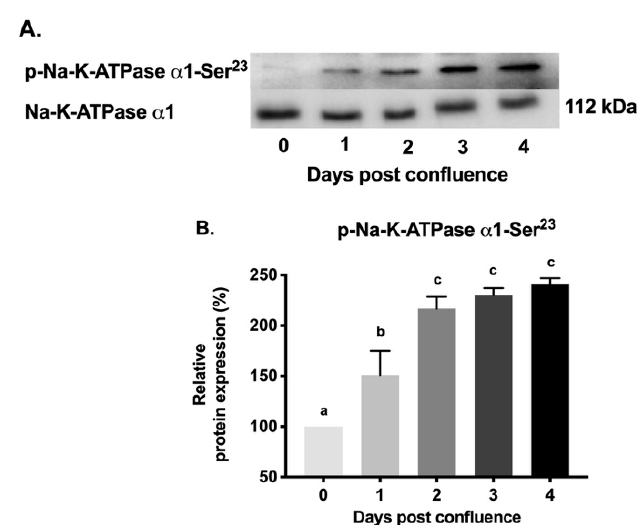
Figure 9. Western blot analysis of plasma membrane Na-K-ATPase α 1-Ser23 at different days of post confluence. ( A ). Representative blot of experiment done in triplicate. ( B ). Densitometric analysis of Western blots. Values are relative to 0-day and normalized to Na-K-ATPase α 1. Values are represented as mean ± SEM, n = 3. Values not sharing common superscripted letters are significantly different at p < 0.01.